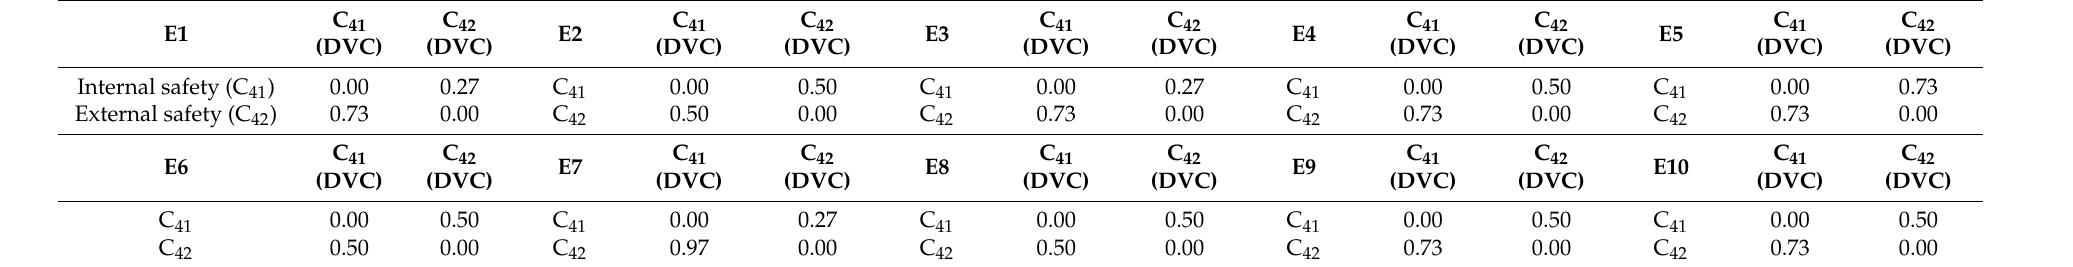
Table A15. The de-fuzzy crisp values for Triangle Fuzzy Numbers in Table